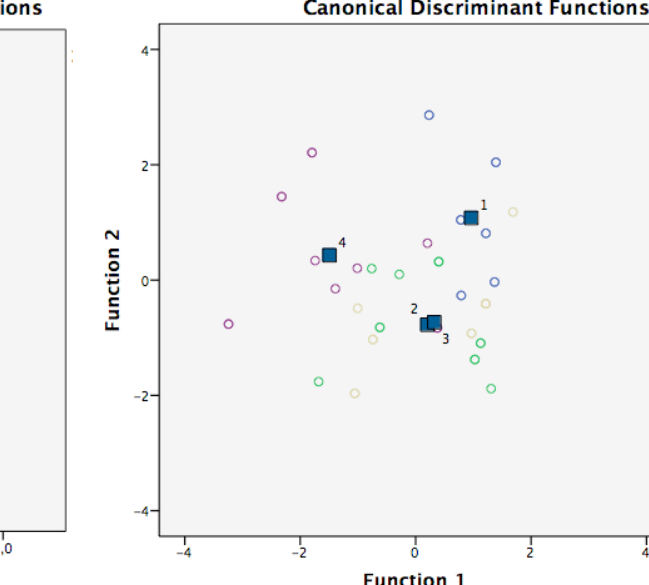
Fig. 4. Dynamics of test results in boys aged 8. CTE12: 1 – load variant І, 2 – load variant ІІ, 3 – load variant ІІI, 4 – load variant